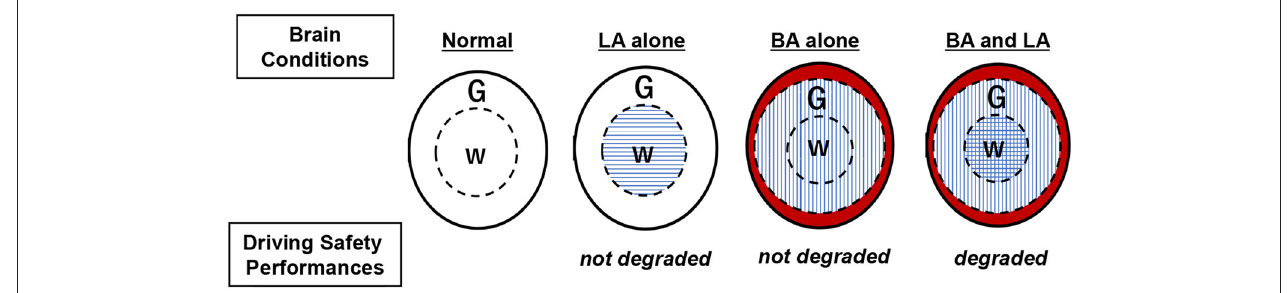
FIGURE 5 | Relationships between brain conditions and degradation of driving safety performances. BA, brain atrophy; LA, leukoaraiosis; G, gray matter; W, white matter. Horizontal line zone shows ischemic change in G due to LA. Vertical line zone shows G and W affected by BA. Red-colored zone indicates brain shrinkage due to